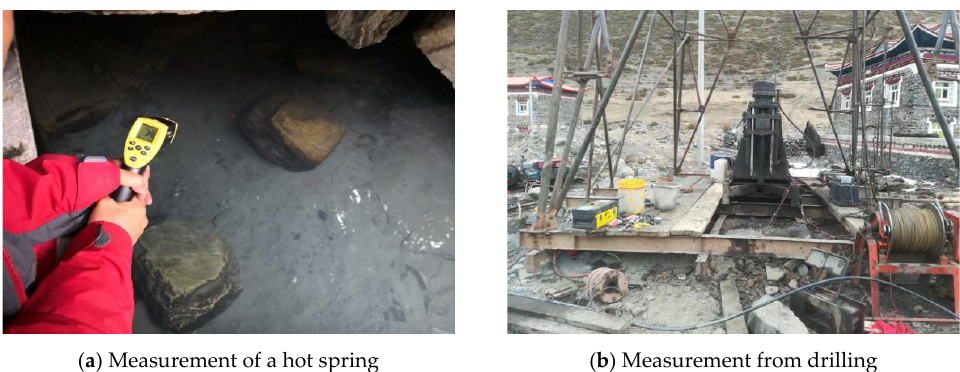
Figure 3. Field temperature measurement of geothermal points.